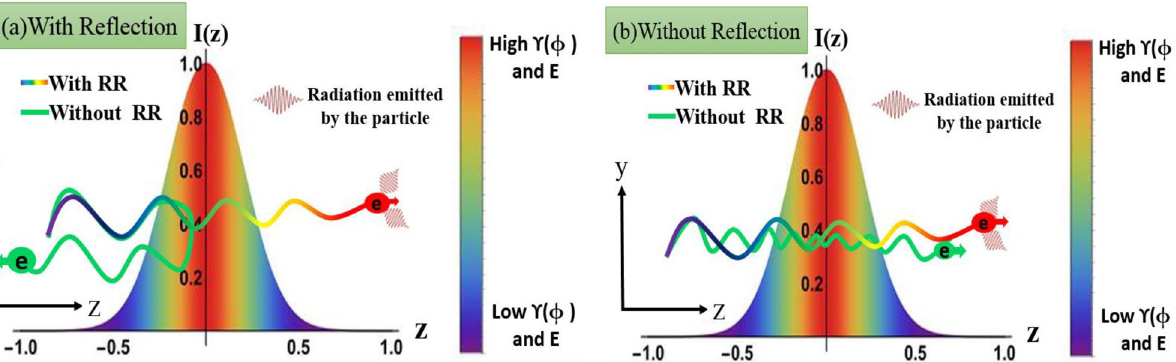
Figure 1. This schematic diagram compares the charged particle dynamics in a focused light wave in the absence/presence of radiation reaction (RR) effects. The variation of laser intensity (hence laser electric field) along the direction of propagation (z-axis) due to focusing is shown by a colour bar. ( a ) and ( b )represent particle trajectories with initial conditions which respectively lead to reflection and transmission through the focal point in the absence of radiation reaction forces (the green wavy lines in ( a ) and ( b )). It is shown that inclusion of radiation reaction forces results in transmission through the focal point in both cases, irrespective of the